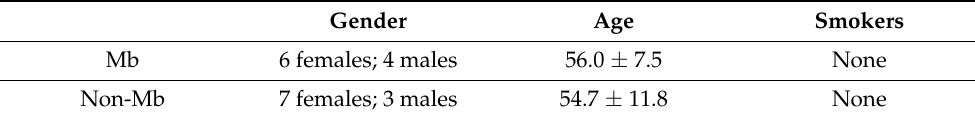
Table 1. Demographic data (n =